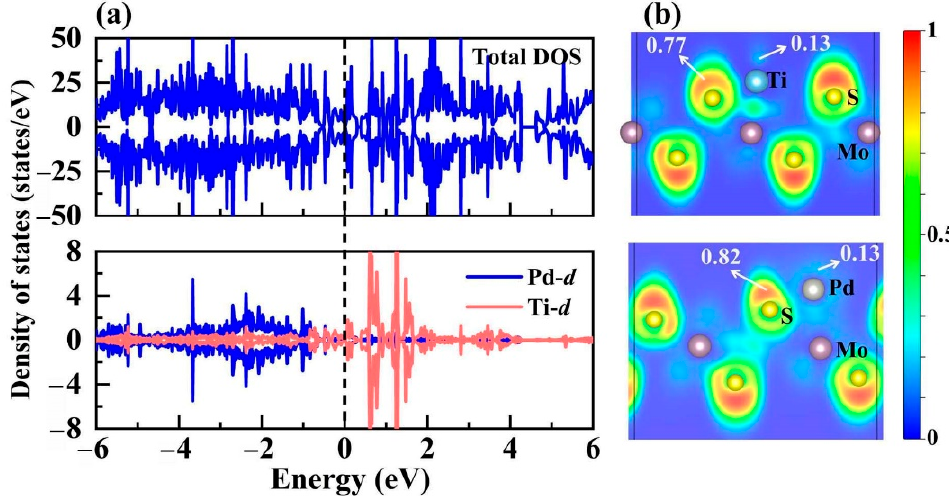
Figure 7. ( a ) Total and projected density of states for PdTi@1T-MoS 2 , as well as ( b ) the electron localization functions (ELF). The Fermi level is set to 0 eV.